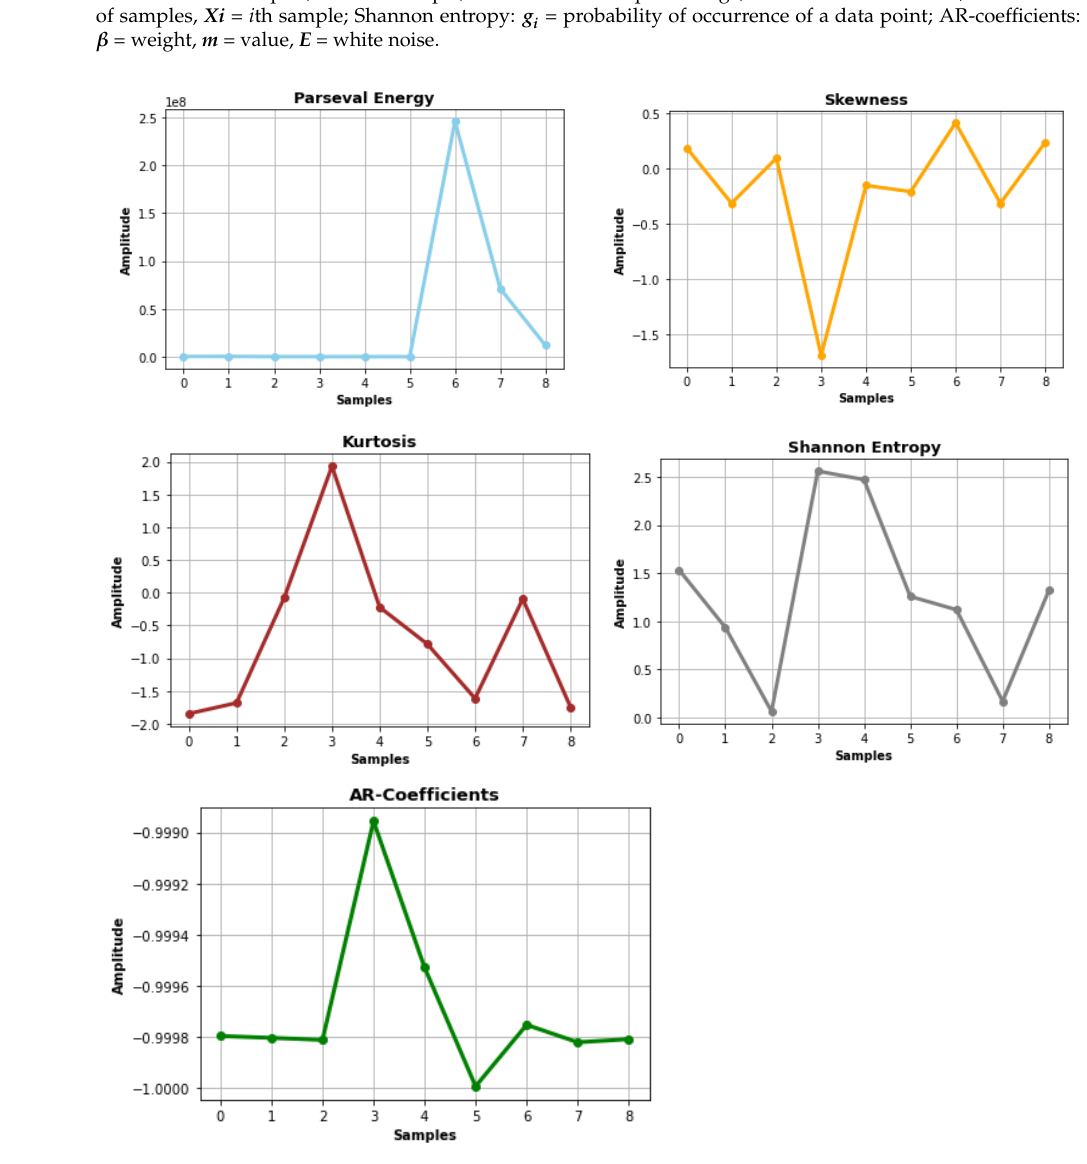
Table 1. Features extracted for human locomotion activity signal.